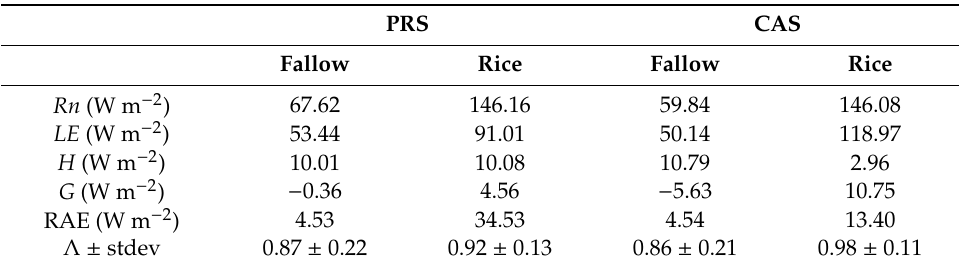
Table 2. Daily averages of the energy balance components (without energy balance closure) during fallow and flooded seasons at the PRS and CAS sites.